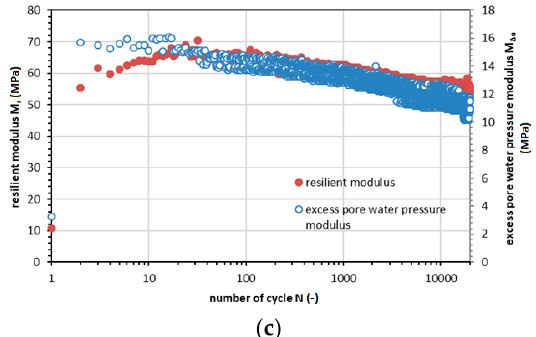
Figure 12. Resilient modulus and excess pore water pressure modulus change during the cyclic loading for isotropic consolidated samples: ( a ) σ ’ 3,0 = 45 kPa, ( b ) σ ’ 3,0 = 90 kPa, and ( c ) σ ’ 3,0 = 135 kPa.